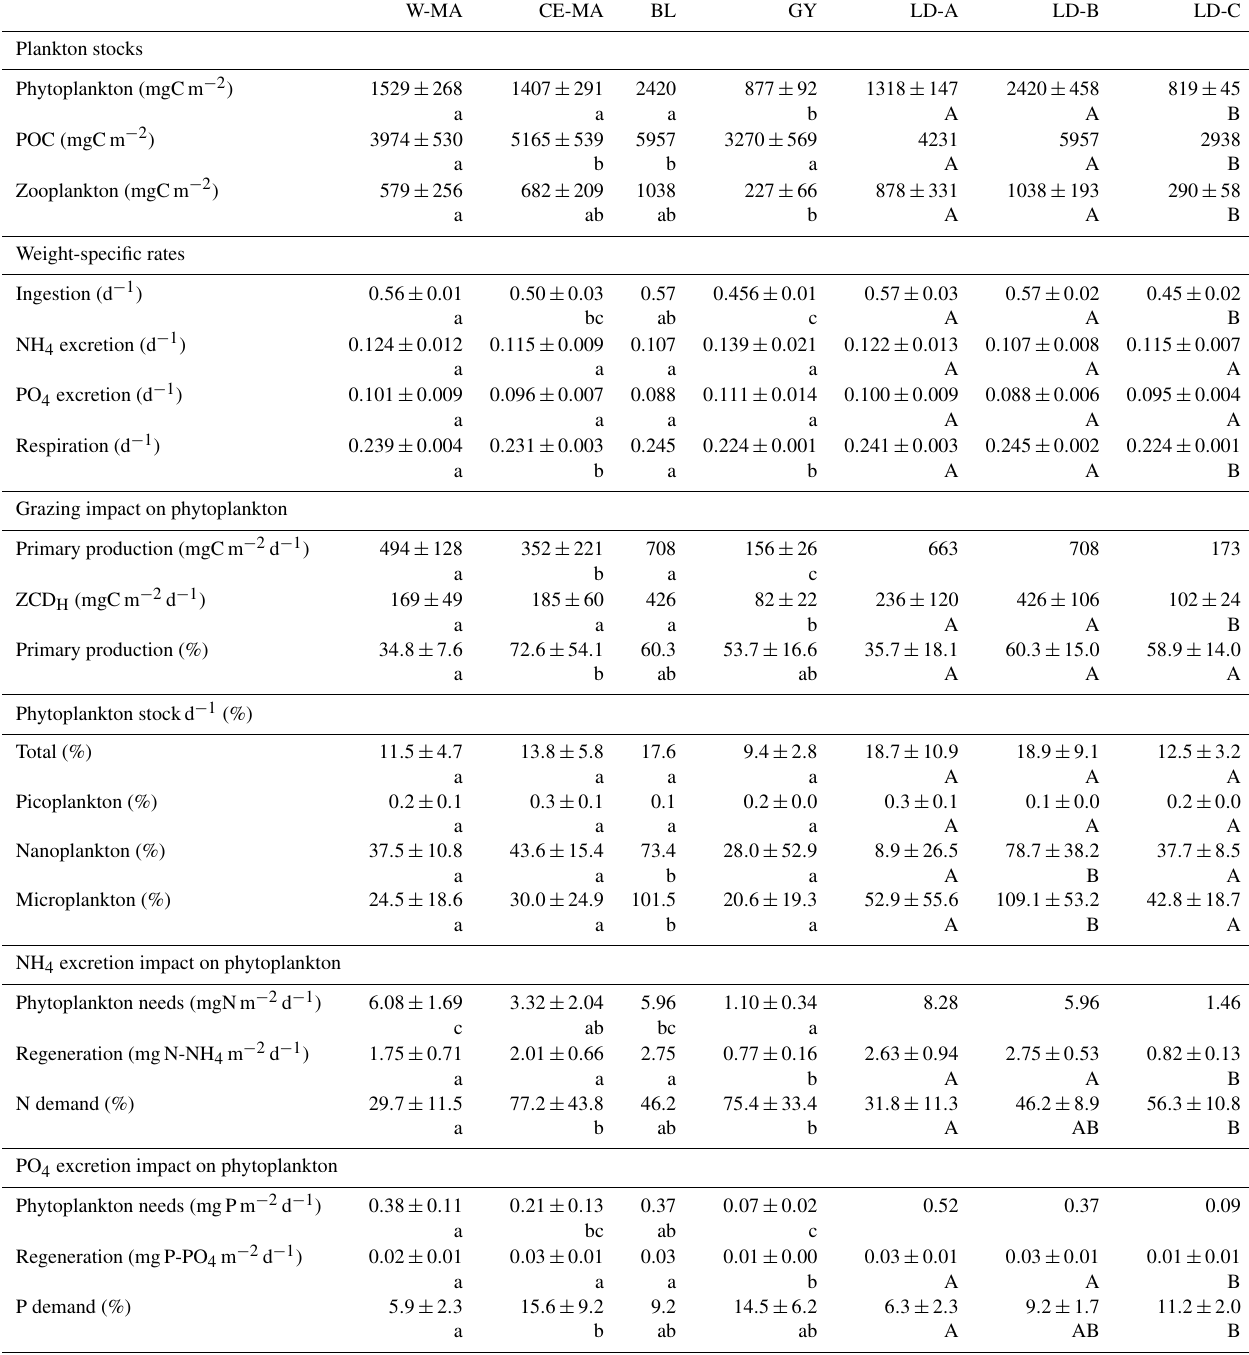
Table 6. Mean values ( ± standard deviation) of plankton stocks, zooplankton weight-specific ingestion, respiration and excretion rates, zooplankton grazing, excretion and respiration fluxes, and zooplankton vertical fluxes. W-MA: western Melanesian archipelago; CE-MA: central and eastern Melanesian archipelago; BL: station B, blooming conditions; GY: subtropical gyre. Letters below the mean values indicate homogeneous groups between zones (small letters) or LD stations (capital letters) according to post hoc Scheffé tests. Zooplankton stocks are estimated from the cumulated biovolume of binocular-counted organisms. Swimmer biomass in sediment trap from Caffin et al.